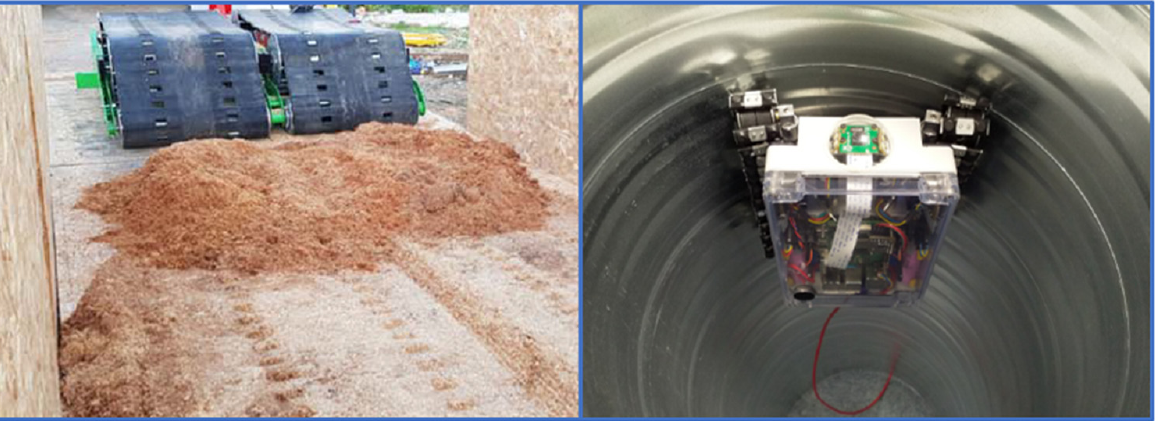
Figure 7. TGMR-CT with flat tracks for flax raw material compacting ( left ); TGMR for pipe inspection with magnetic locomotion ( right ).